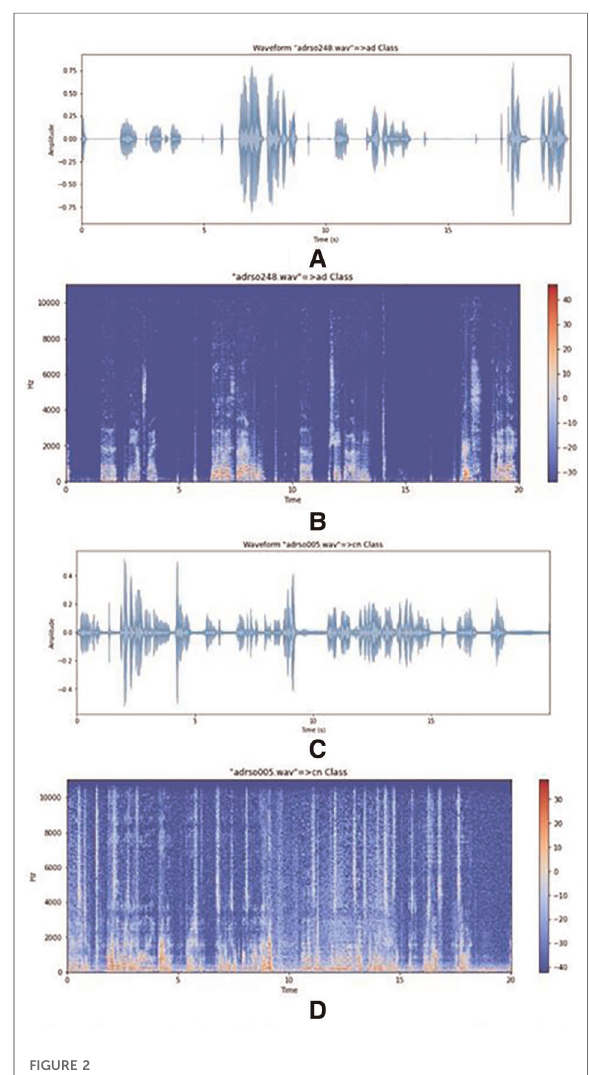
FIGURE 2 ( A ) plot of an AD speech signal. ( B ) Spectrogram of an AD speech signal. ( C ) Plot of a CN signal. ( D ) Spectrogram of a CN signal.